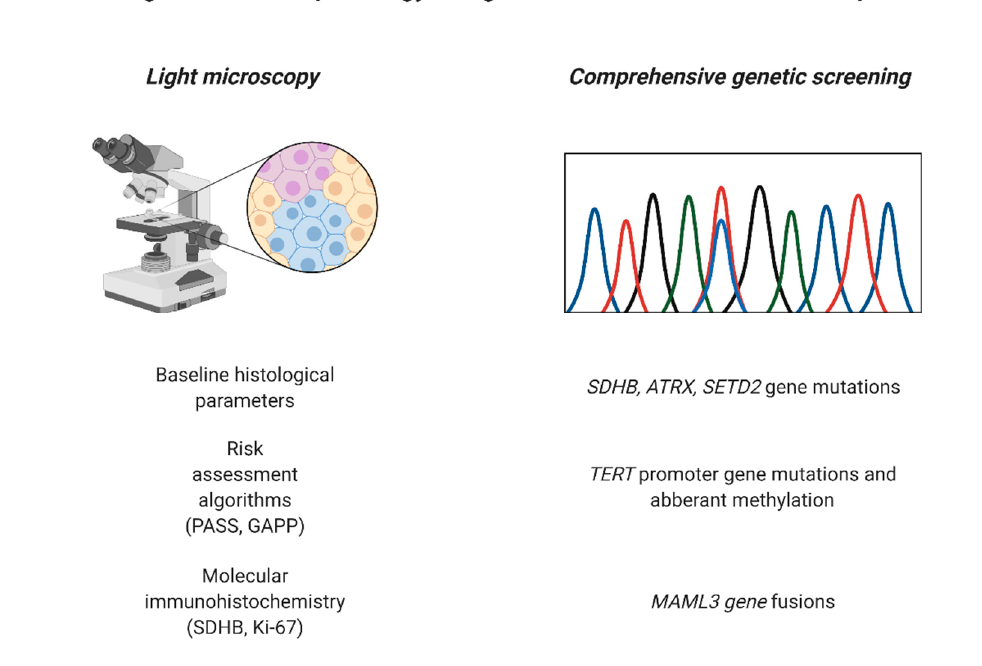
Figure 5. Potential future work-up of pheochromocytomas and abdominal paragangliomas may require a combination of histology and molecular immunohistochemistry as well as screening for somatic genetic aberrations in order to facilitate the detection of cases with the potential to metastasize. Created with BioRender.com.